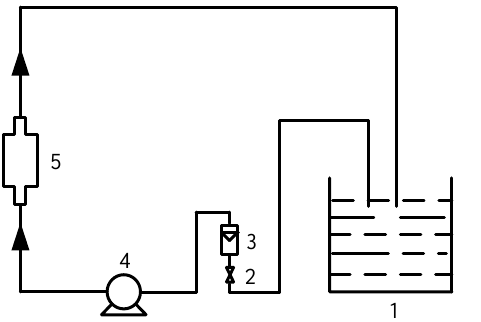
Figure 2. Schematic diagram of magnetization equipment system. 1, Flume; 2, saving flux valve; 3, flux meter; 4, pump; 5, magnetizer.